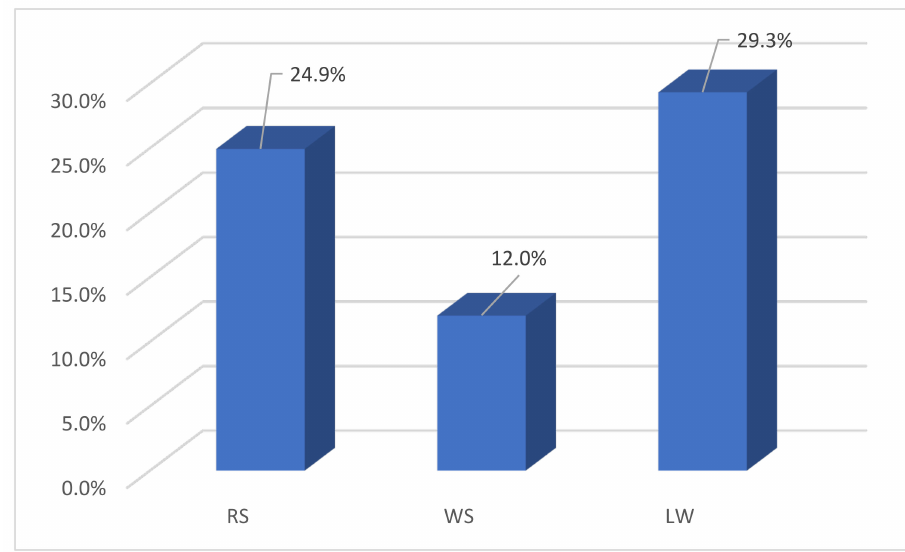
Figure 8. Average %|diff| of A-VaNSAS KPIs.